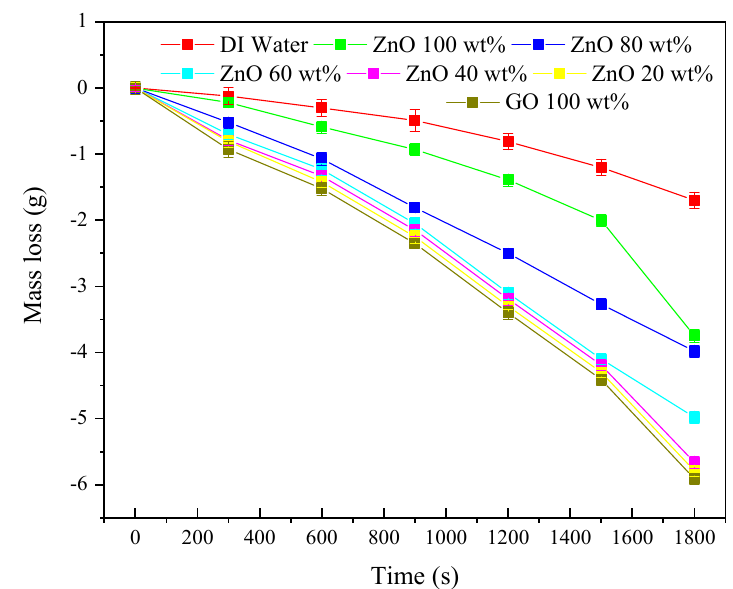
Figure 10. Mass loss for a specific time duration for binary nanofluids ZnO–GO under a natural sun over the period of 1800 s of DI water base nanofluids at 0.0004 wt % concentrations.